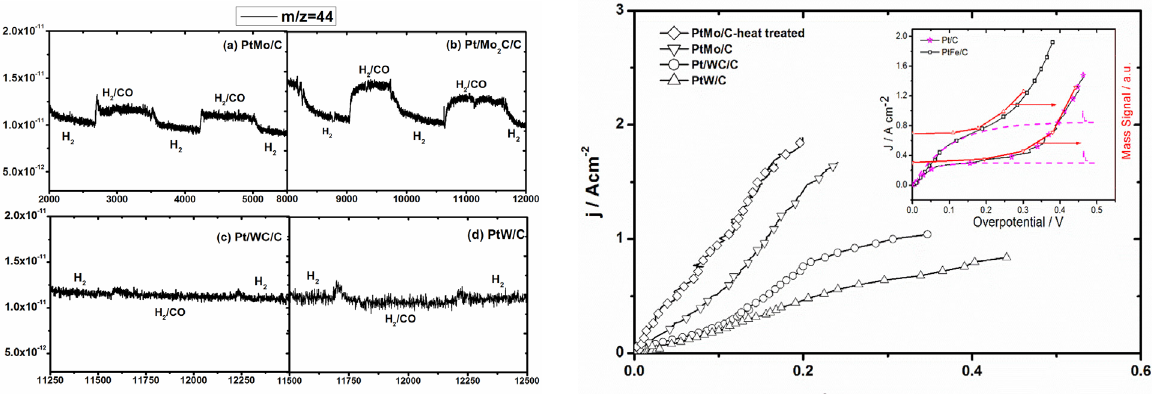
Figure 7 - Online mass spectrometry experiments of m/z= 44 ionic current measurements for the PtMo/C, Pt/Mo WC-C and PtW/C anodes at 85 °C fed intermittently with pure H or H /CO mixtures. O is supplied continuously to the Pt/C 2 2 2